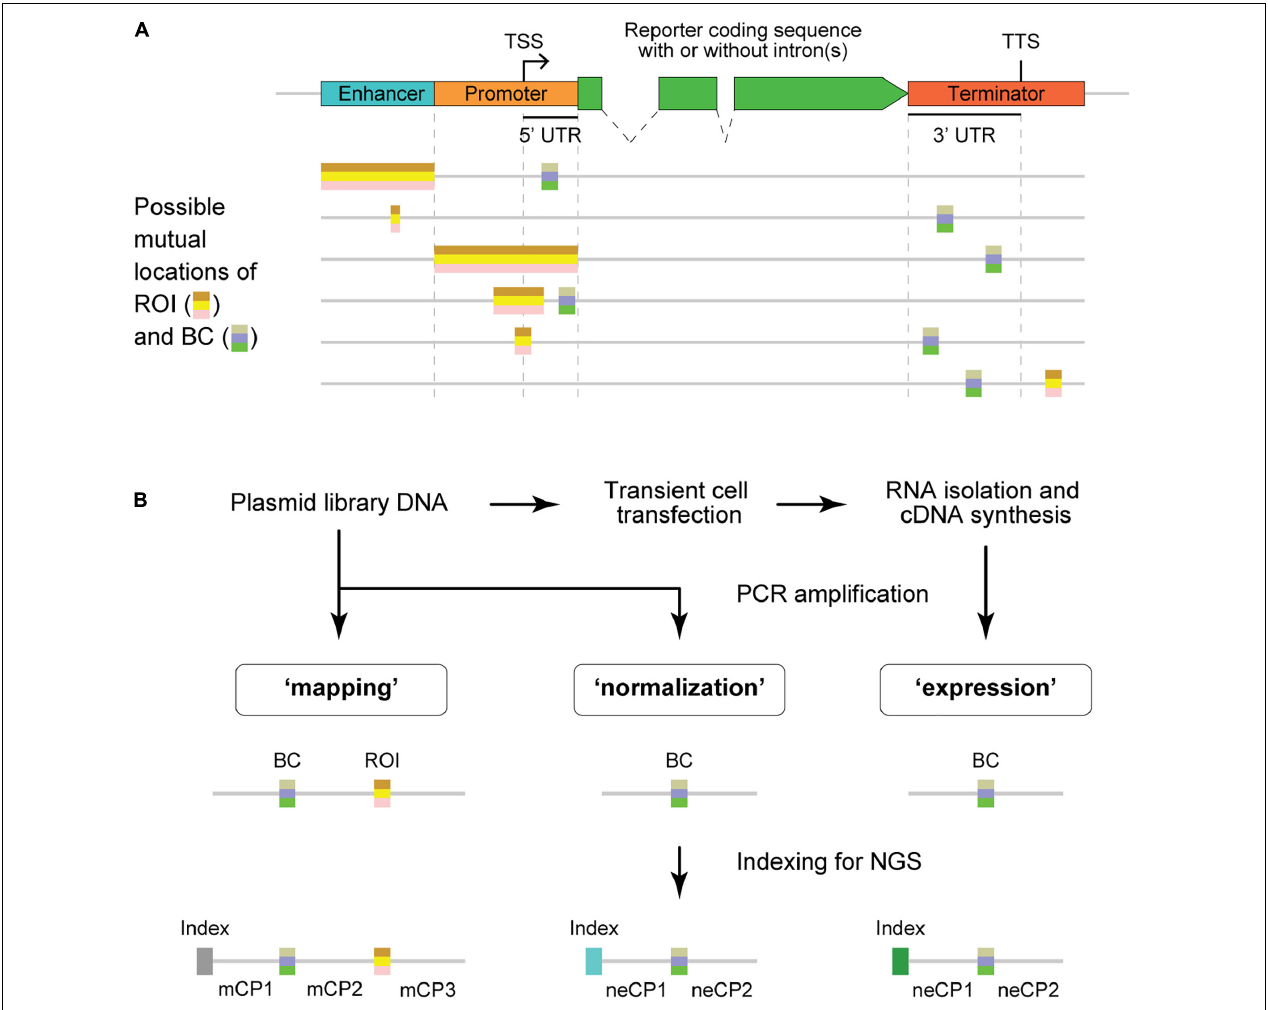
FIGURE 1 | Structure of MPRA constructs and samples. (A) Schematic representation of typical MPRA reporter constructs with two variable regions, the region of interest (ROI) and barcode (BC). An enhancer element may be missing in particular MPRA constructs. The ROI is usually located outside the coding sequence, whereas the BC must be within the transcribed unit to ensure measurements of the ROI influence on the reporter expression level. TSS, transcription start site; TTS, transcription termination site; UTR, untranslated region. (B) Schematic showing the experimental steps involved in the preparation of MPRA samples and their structures. Note that the normalization and expression samples have identical structures; the mapping sample is required only for MPRA libraries in which BC–ROI associations are not predetermined. mCP, constant part present in the sequence of the mapping sample; neCP, constant part present in the sequence of the normalization/expression